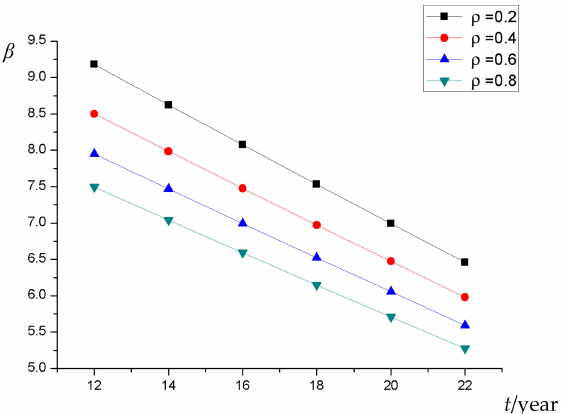
Figure 11. Non-probabilistic non-varying reliability indexes considering the interaction of corroded length and